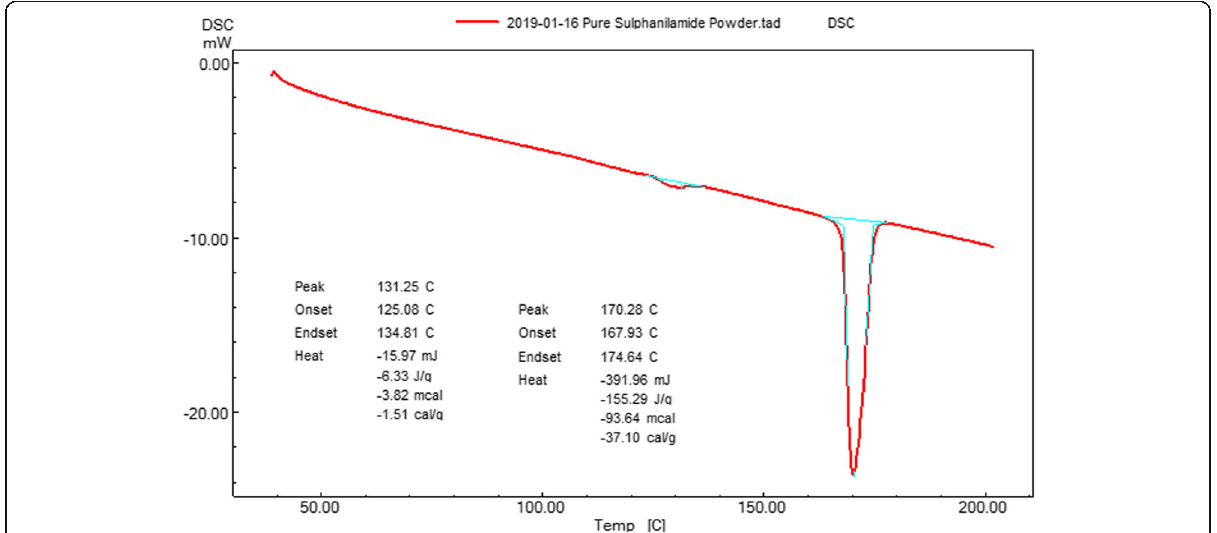
Fig. 4 DSC scan of pure Sulphanilamide. It matches with the DSC scan of commercially available pure